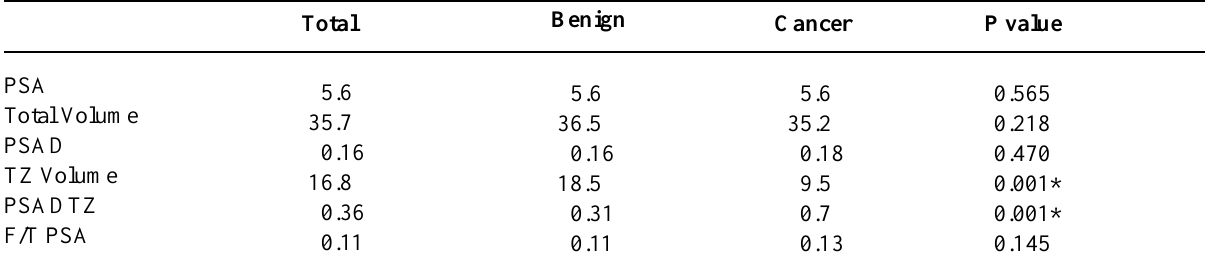
Table 2 – Association between pathology examination and PSA parameters (medians) in the general group.